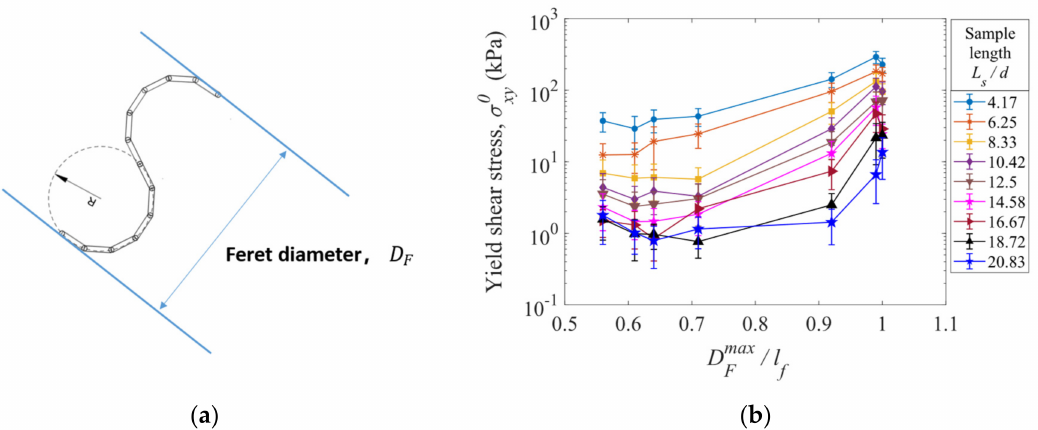
Figure 18. ( a ) An illustration of Feret diameter of a fiber. ( b ) Yield shear stress versus normalized maximum Feret diameter of a fiber, D max / l f , for various sample lengths. The half-length of an error F bar represents a standard deviation from the average value at the steady state of shearing